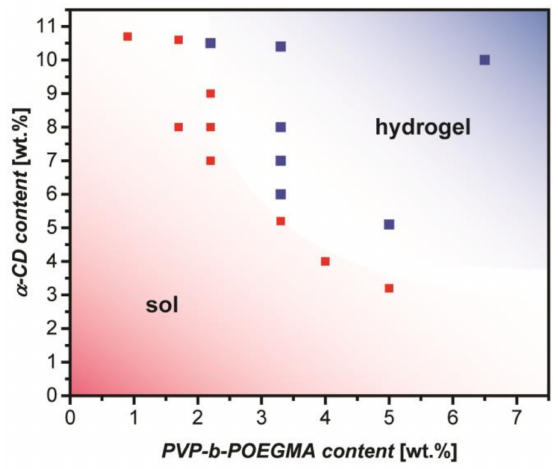
Figure 2. Phase diagram of PVP 41k - b -POEGMA 22k / α -CD mixtures: blue data points correspond to hydrogel and red data points correspond to